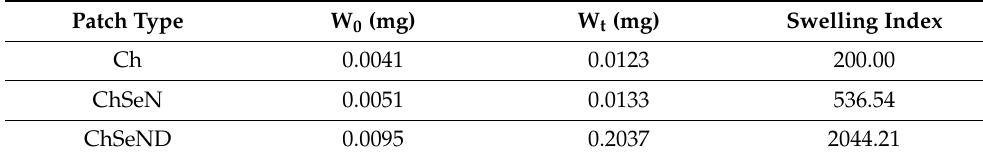
Table 1. Swelling index of different patches.